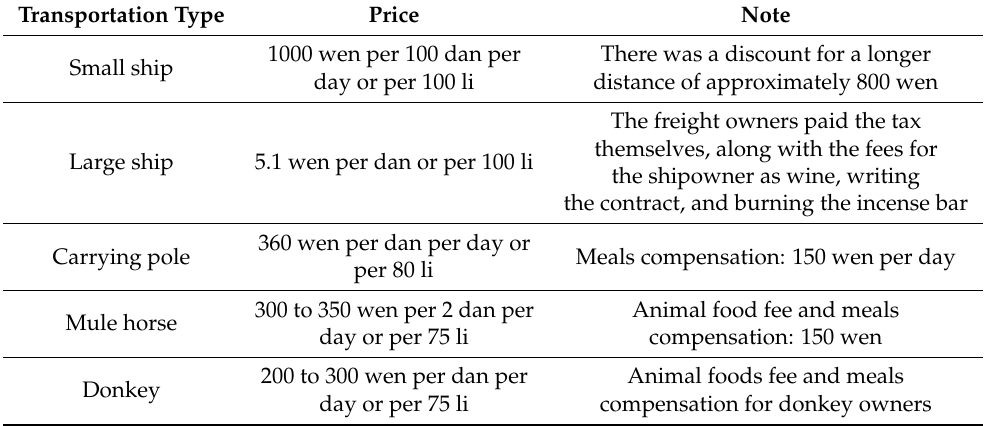
Table 1. Price list of passenger transport in the Jiangnan region of China at the end of the 19th century. Transportation Type Price Note 120 wen per person per day Small ship or per 100 li 185 wen per person per day No steamship competition plus Large ship or per 100 li liquor charge 133 wen per person per day With steamship competition plus Large ship or per 100 li liquor charge 150 wen as the labor’s meals 360 wen per person per day compensation, total was 630 wen per Sedan chair or per 80 li person per 100 li 350 wen per person per day Only available in a few locations Mule horse or per 75 li Plus animal food fee and meals Donkey 200 wen per person per day compensation for donkey owners